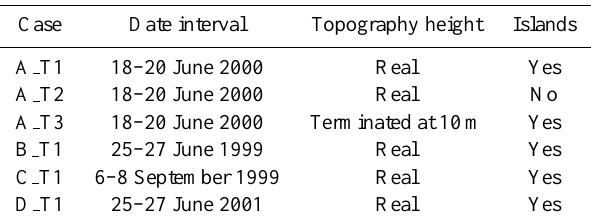
Table 1. Simulations performed in the present study.